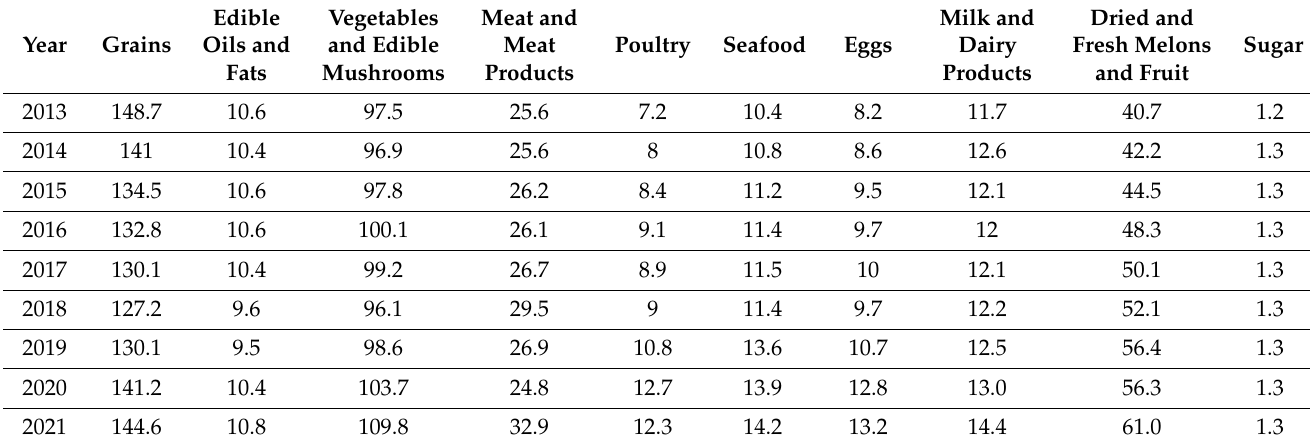
Table 1. Per capita consumption of major foods by Chinese residents from 2013 to 2021 [51]. Unit: